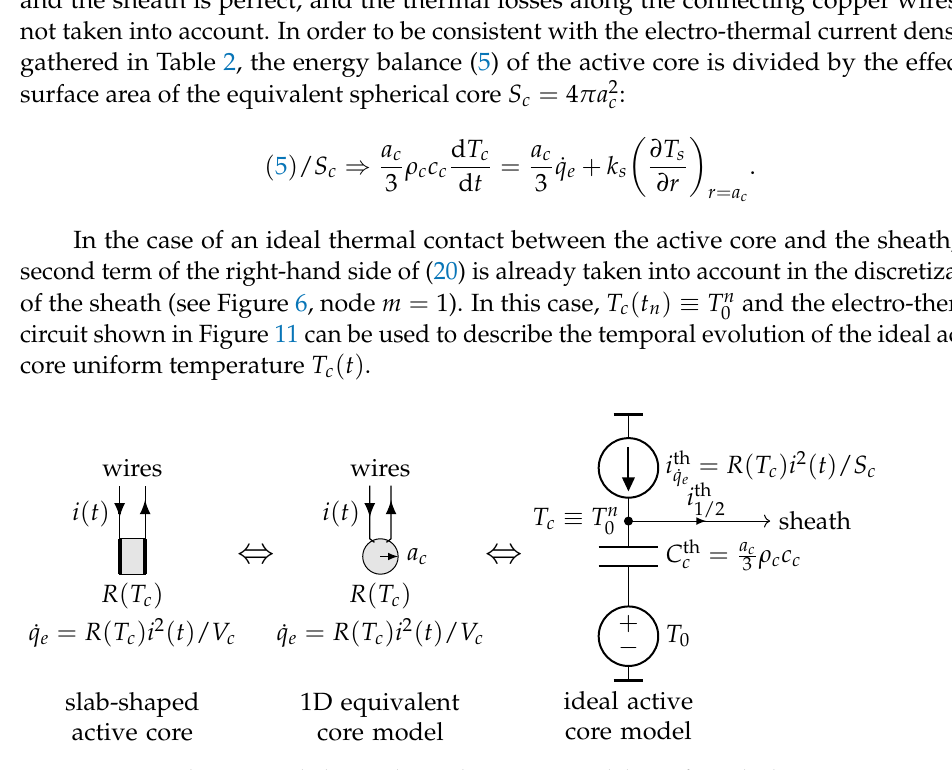
Figure 11. One-dimensional electro-thermal systemic modeling of an ideal NTC active core with electrical resistance R ( T c ) given by Equation (1) or (2). Recall that the effective radius a c is chosen so that the volume V c of the equivalent spherical core is equal to that of the